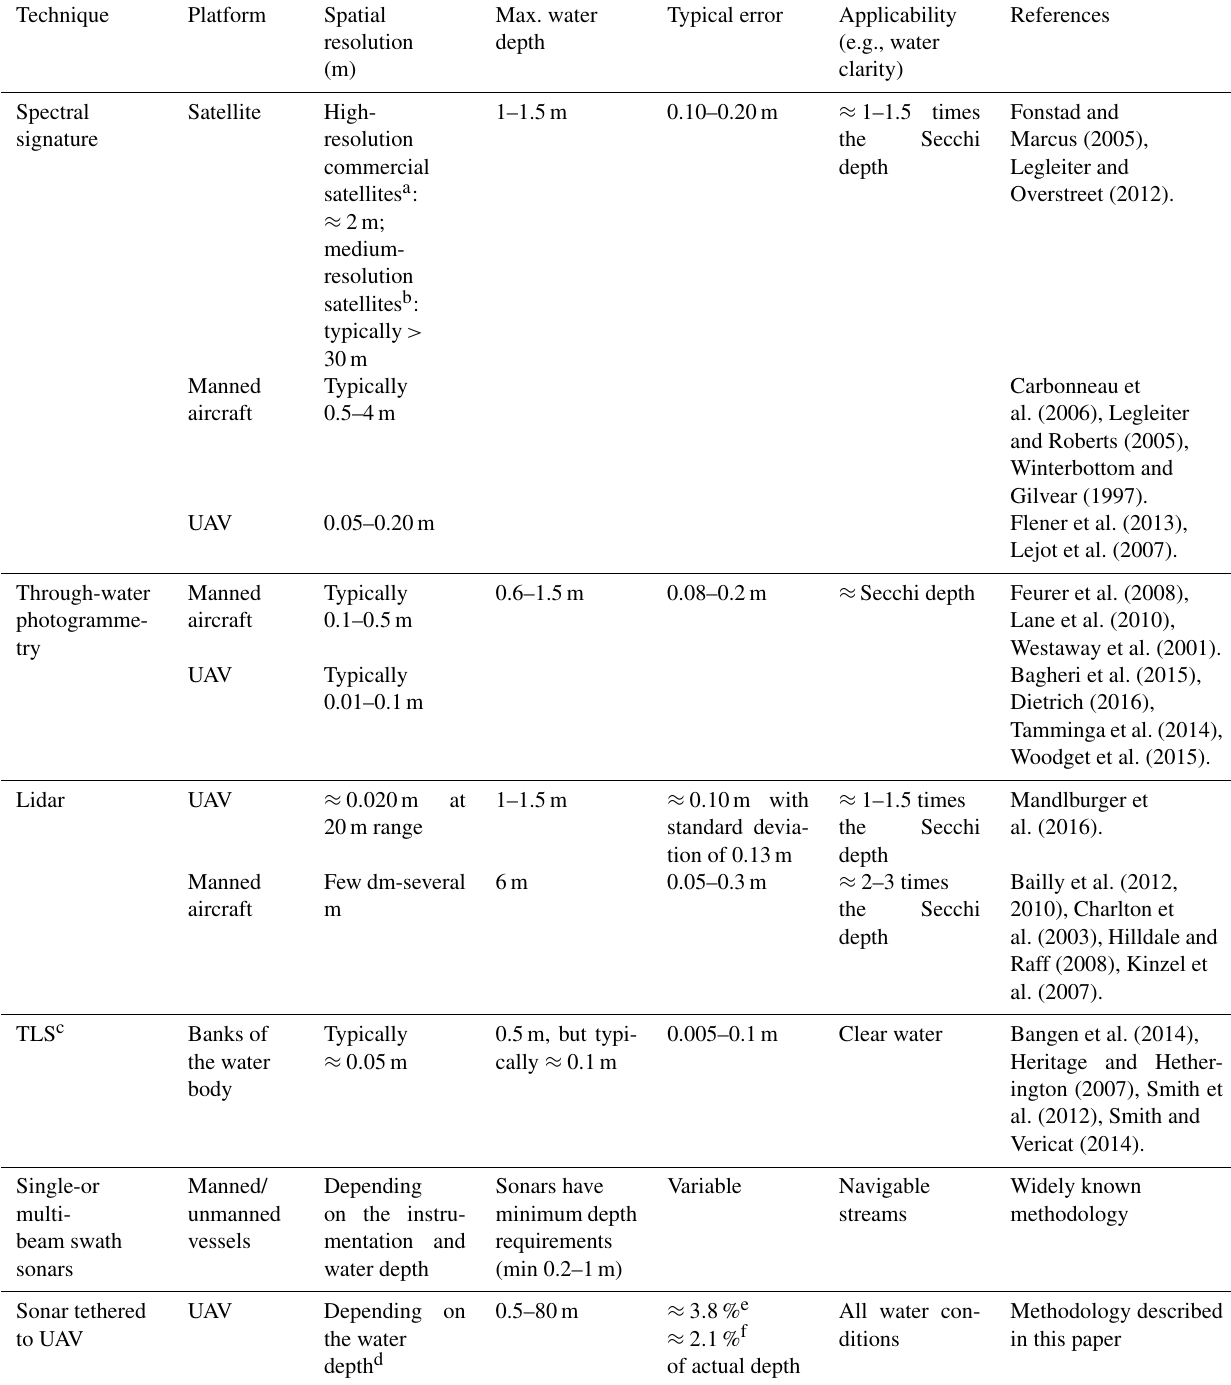
Table 3. Comparison of different approaches for measuring river